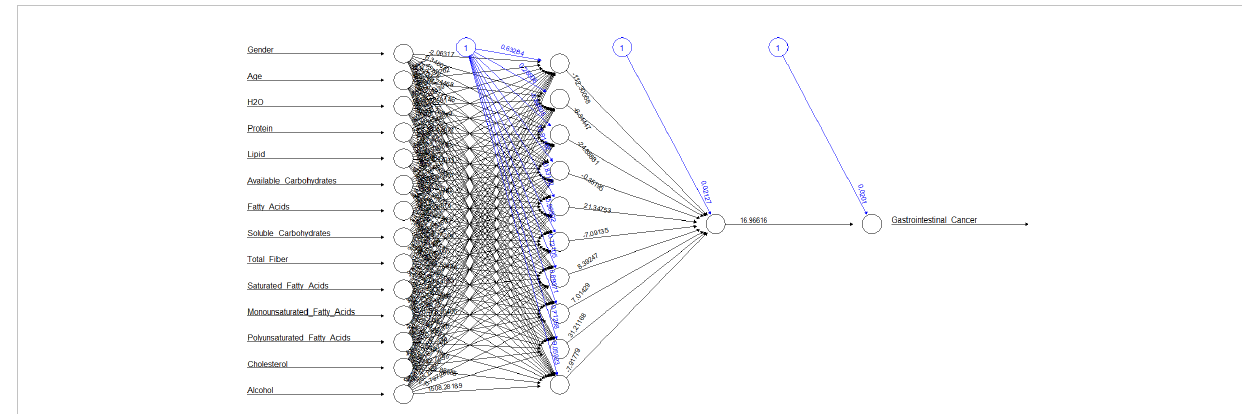
FIGURE 2 The ANN on the training dataset of macronutrients.